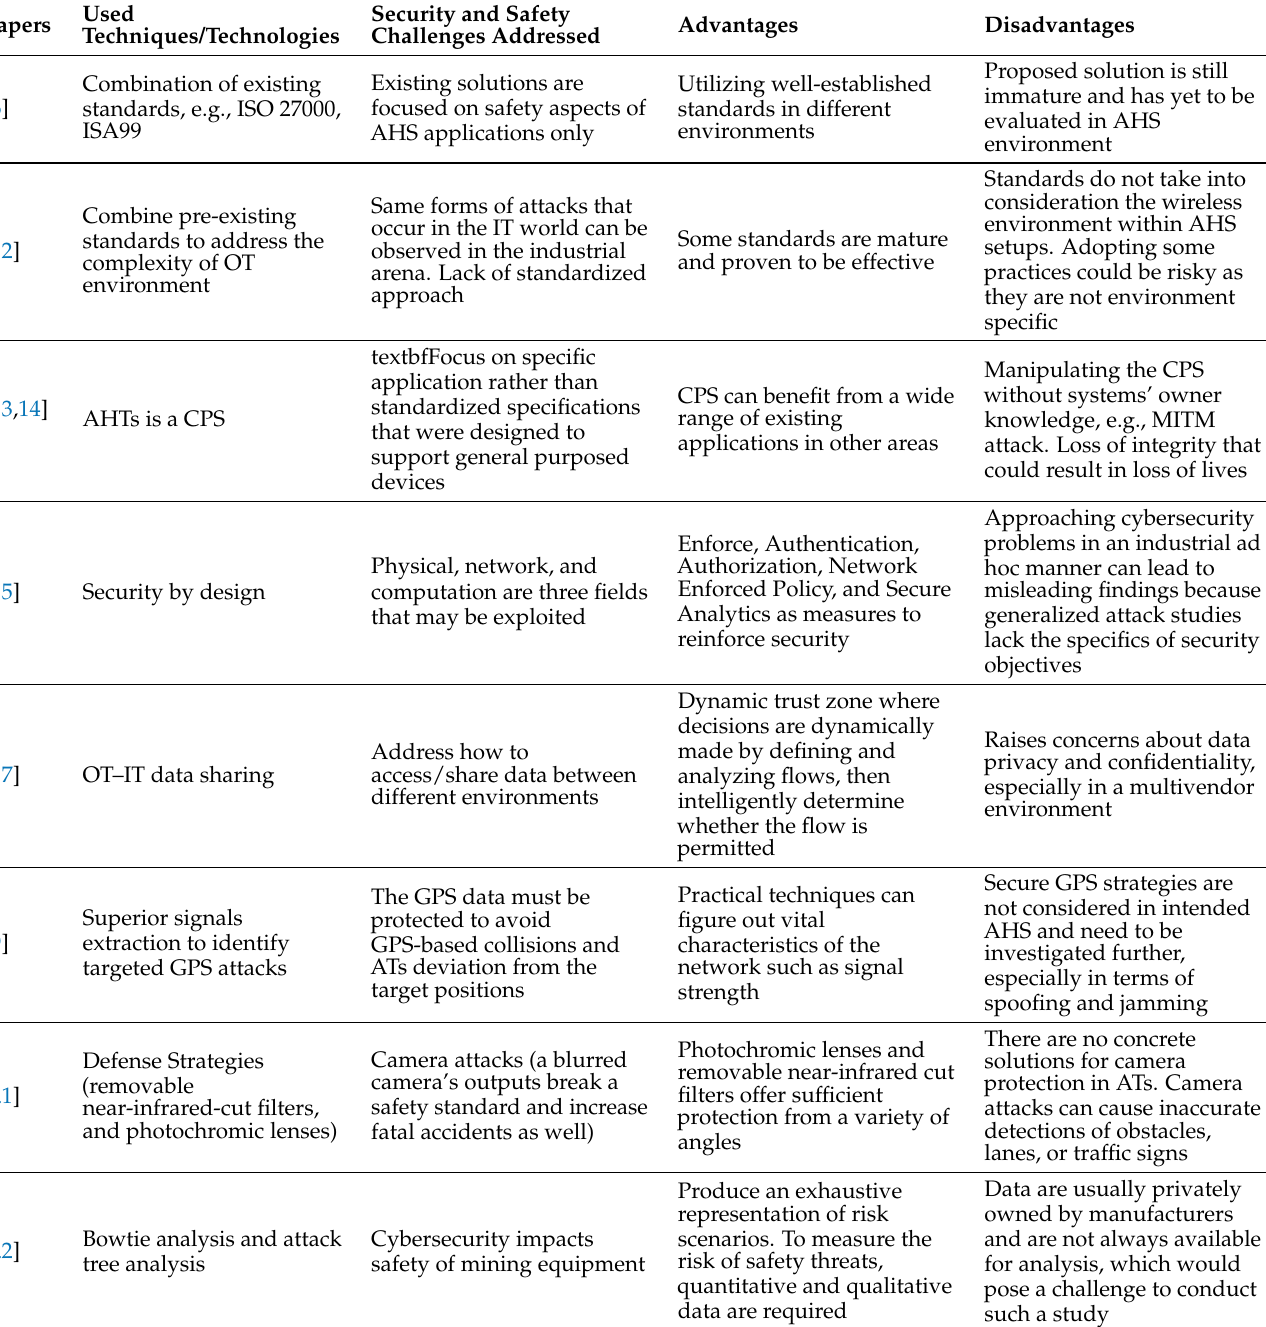
Table 1. Summary of literature on cybersecurity and